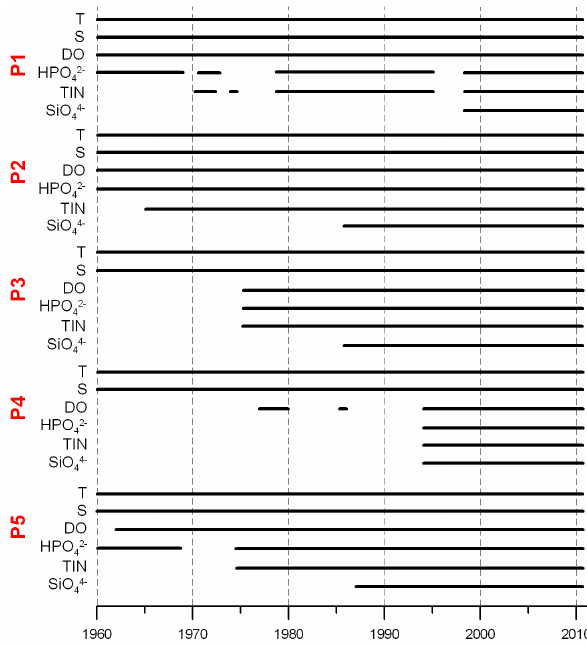
Fig. 2. Availability of the data collected at the Palagruˇza Sill tran-